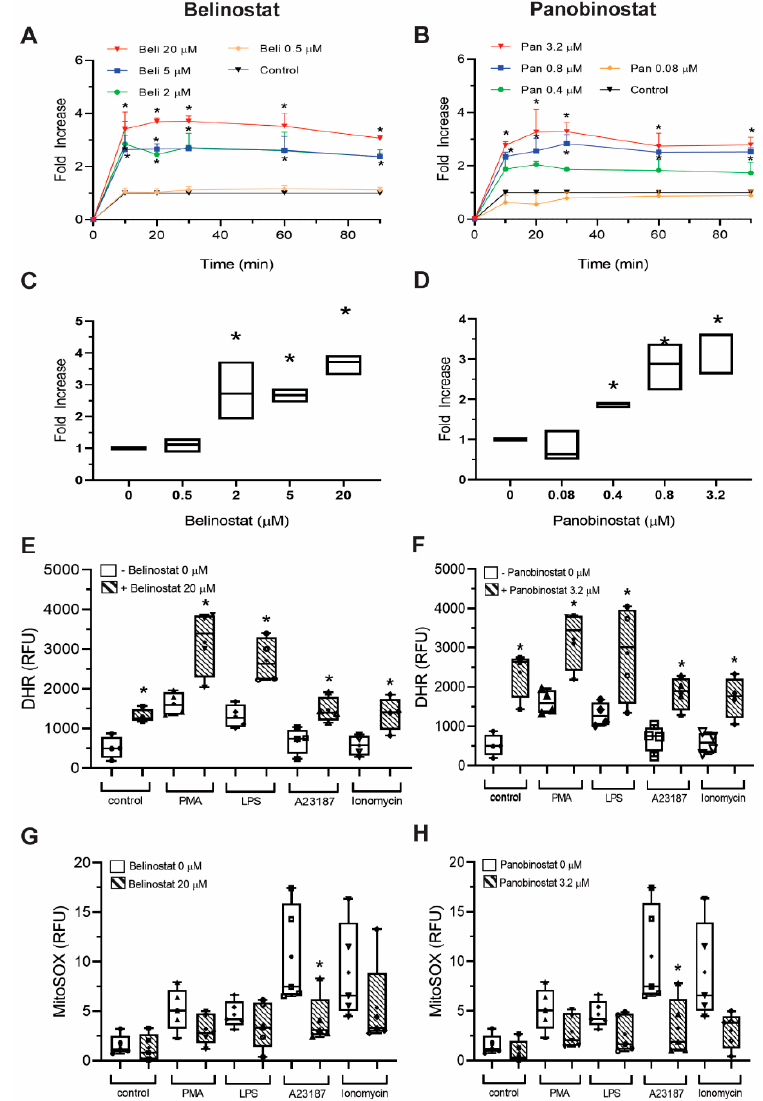
Figure 9. Concentrations of HDACis induce cytosolic but not mitochondrial ROS production. ( A–D ) DHR123 assays measuring NOX-derived ROS production of neutrophils treated with HDACis (0.5, 2, 5 and 20 µ M belinostat; 0.08, 0.4, 0.8 and 3.2 µ M panobinostat) every 10 min for up to 90 min by using a fluorescence plate reader. Neutrophils treated with belinostat ( A,C ) or panobinostat ( B,D ) show a dose-dependent increase of cytosolic ROS levels. ( C–D ) DHR123 assays at 30 min post-HDACis treatment. ( E–H) DHR123 and MitoSOX assays measuring NOX- and mitochondrial-derived ROS production of neutrophils treated with HDACis (20 µ M belinostat; 3.2 µ M panobinostat) at 30 min, respectively. Neutrophils treated with belinostat ( E,G ) or panobinostat ( F,H ) promote intracellular ROS, but not mROS levels. ROS generation data assessed by using DHR123 ( A–F ), while by MitoSOX. ( G,H ) Kinetics data are presented as mean ± SEM (Two-Way ANOVA with Dunnett post-test; n = 3). In box graphs, full data spread is indicated with lines and boxes are marked with the mean ( + ), median and upper and lower interquartile ranges. *, p < 0.05 (One-Way ANOVA with Tukey post-test conducted at each time points; n = 3, 4). See Supplementary Figures S7 and S8 for additional information.